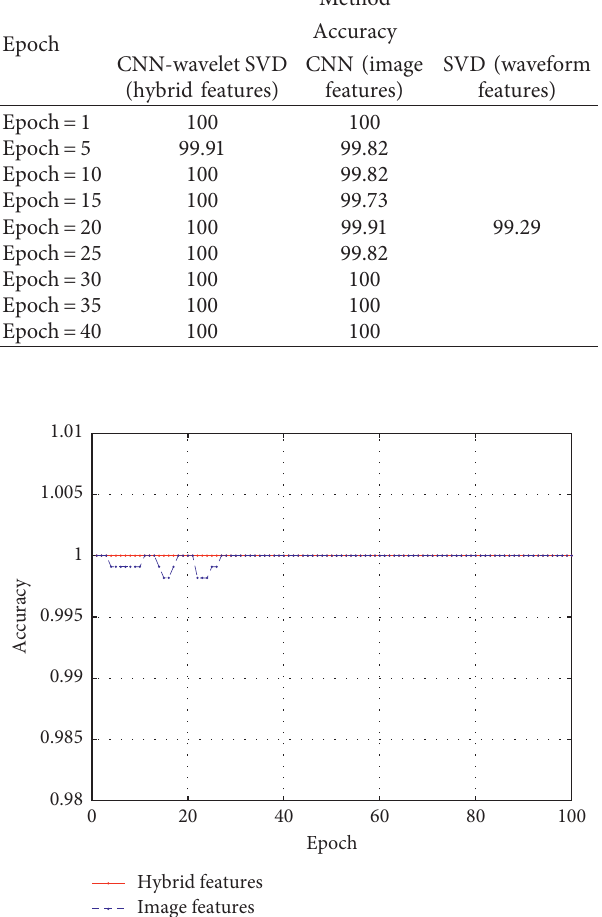
Figure 13: Recognition rate of SVM on different features.